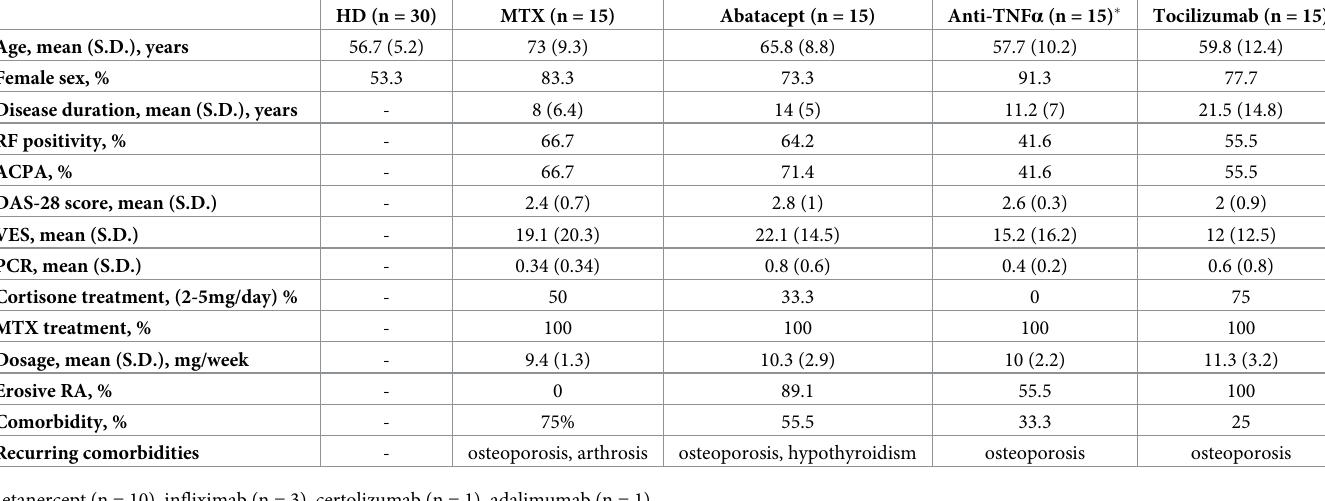
Table 1. Characteristics of healthy donors and RA